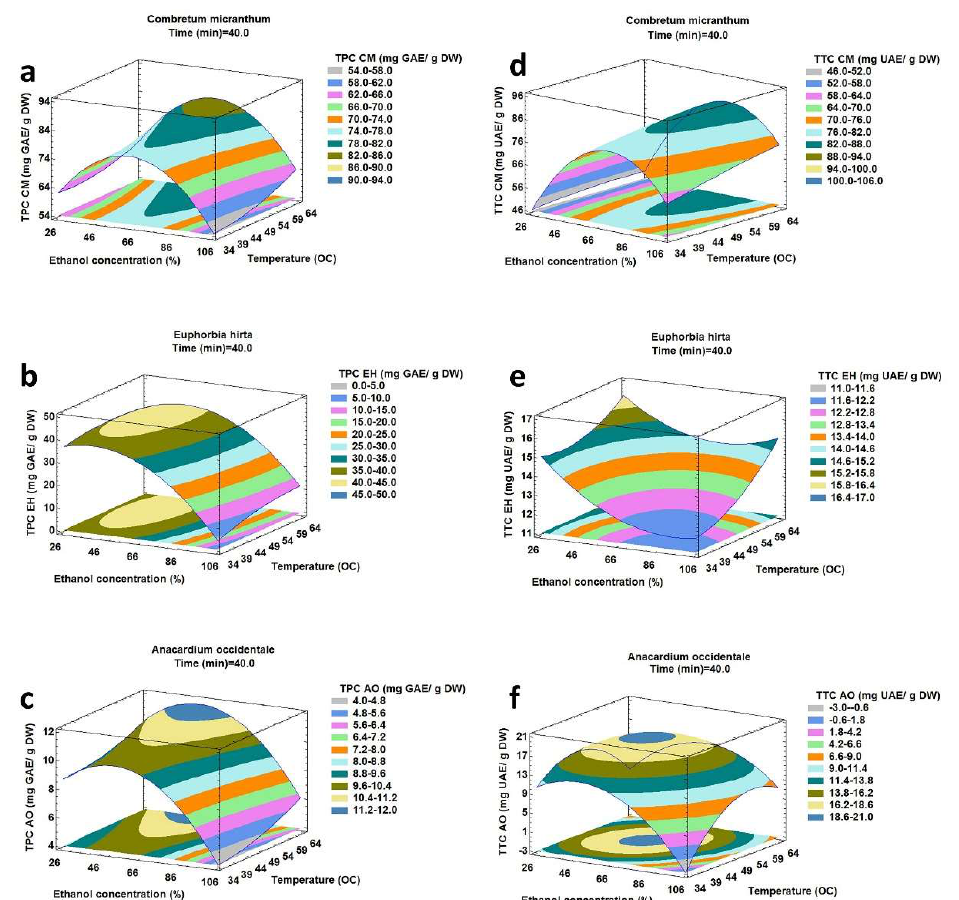
Figure 2. Response surface plot showing the effect of ethanol concentration and extraction temperature on total phenolic and total triterpenoid compounds from Combretum micranthum ( a , d ), Euphorbia hirta ( b , e ) and Anacardium occidentale ( c , f ) corresponding to extraction time of 40 min. These show that TPC increased when the extraction temperature increased. Indeed, an augmentation of extraction temperature increased the solvent diffusivity into the plant matrix and enhanced the desorption and solubility of the targeted compounds [31]. Until the optimum temperature was reached, TPC increased with increasing ethanol concentration, but beyond a certain